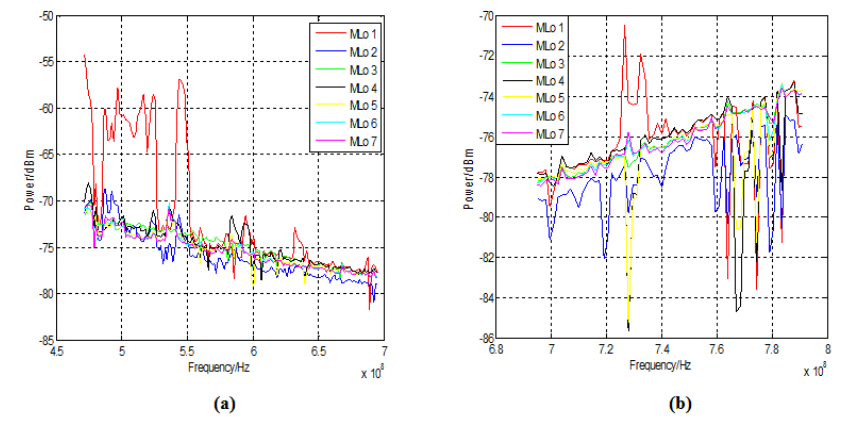
Figure 5. Radiofrequency intensities at various measurement locations for the 3 km distance from the transmitter. The frequency ranges are 470 MHz-694 MHz for (a) and 694 MHz -790 MHz for (b)